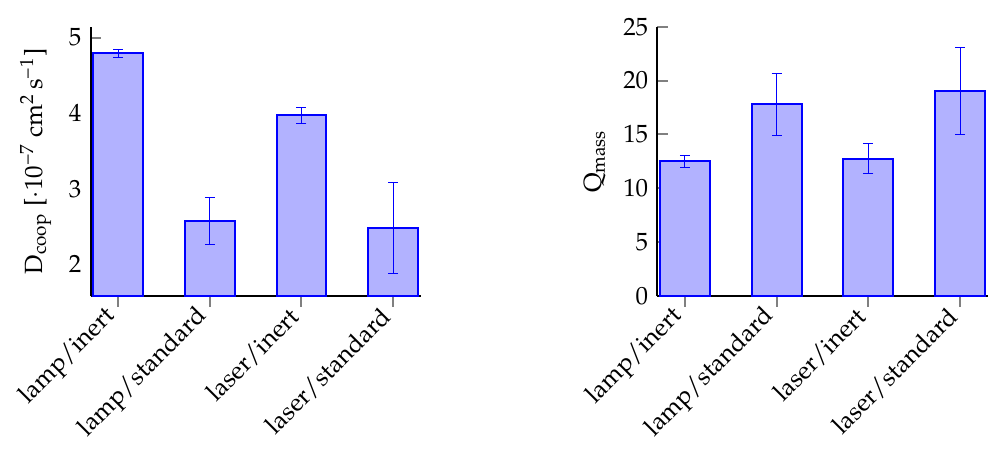
Figure 6. Process reproducibility with the cooperative diffusion coefficient D coop and the degree of swelling Q as characterisation